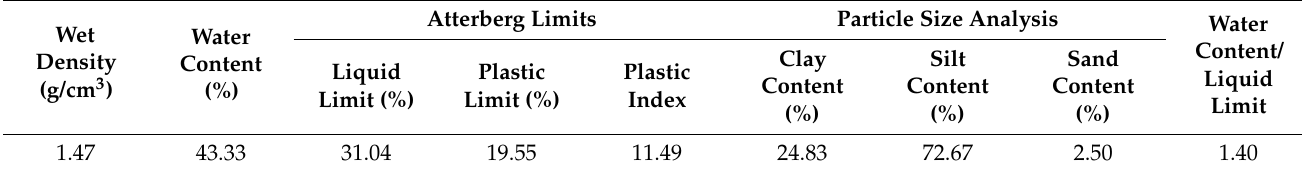
Table 1. Physical index properties of the sediments. The data represent mean